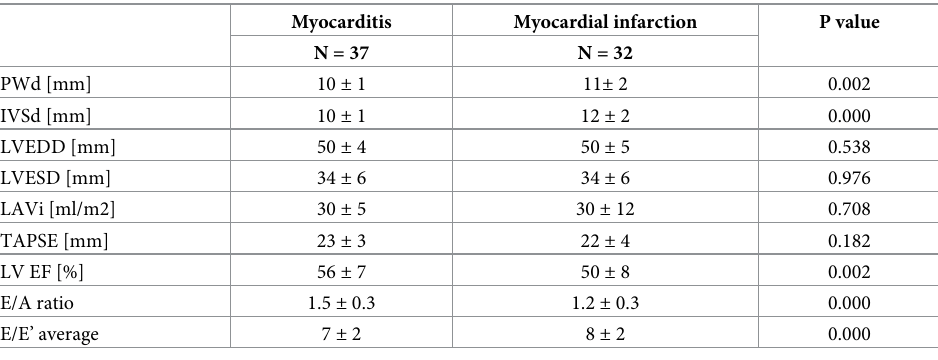
Table 2. Baseline echocardiographic parameters.